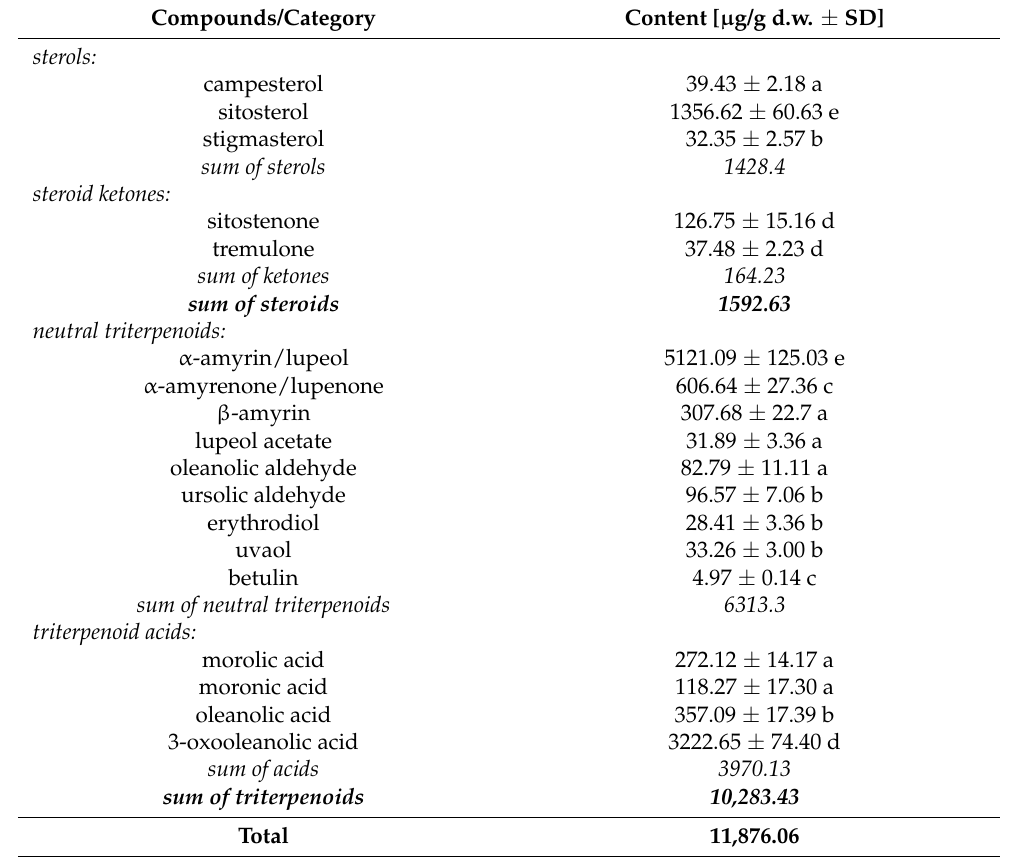
Table 4. Content of steroids and triterpenoids in Pistacia lentiscus